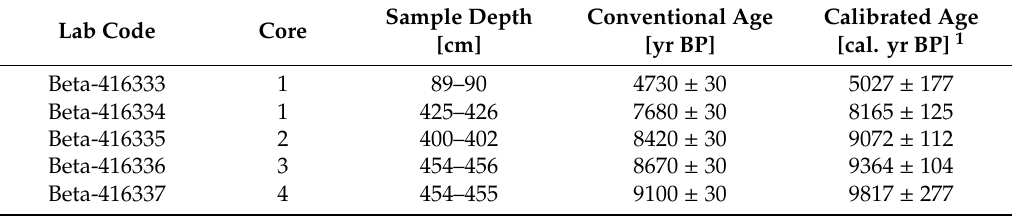
Table 3. Details of the AMS 14 C age determinations. Sample material was calcareous shell fragments. Sample Lab Code Core